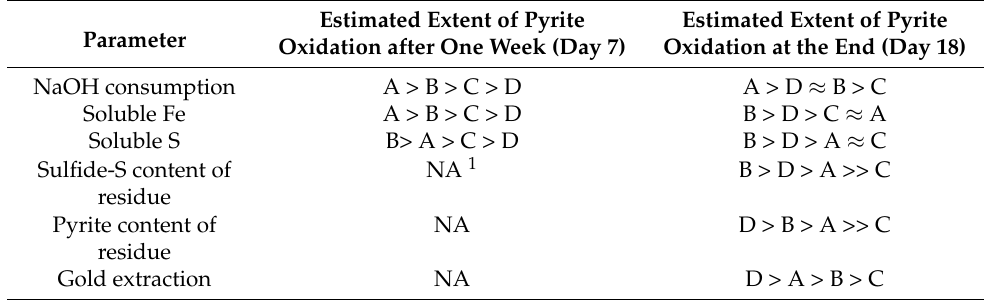
Table 8. The order of the extent of pyrite oxidation in reactors A–D as estimated based on various parameters after one week and at the end of the